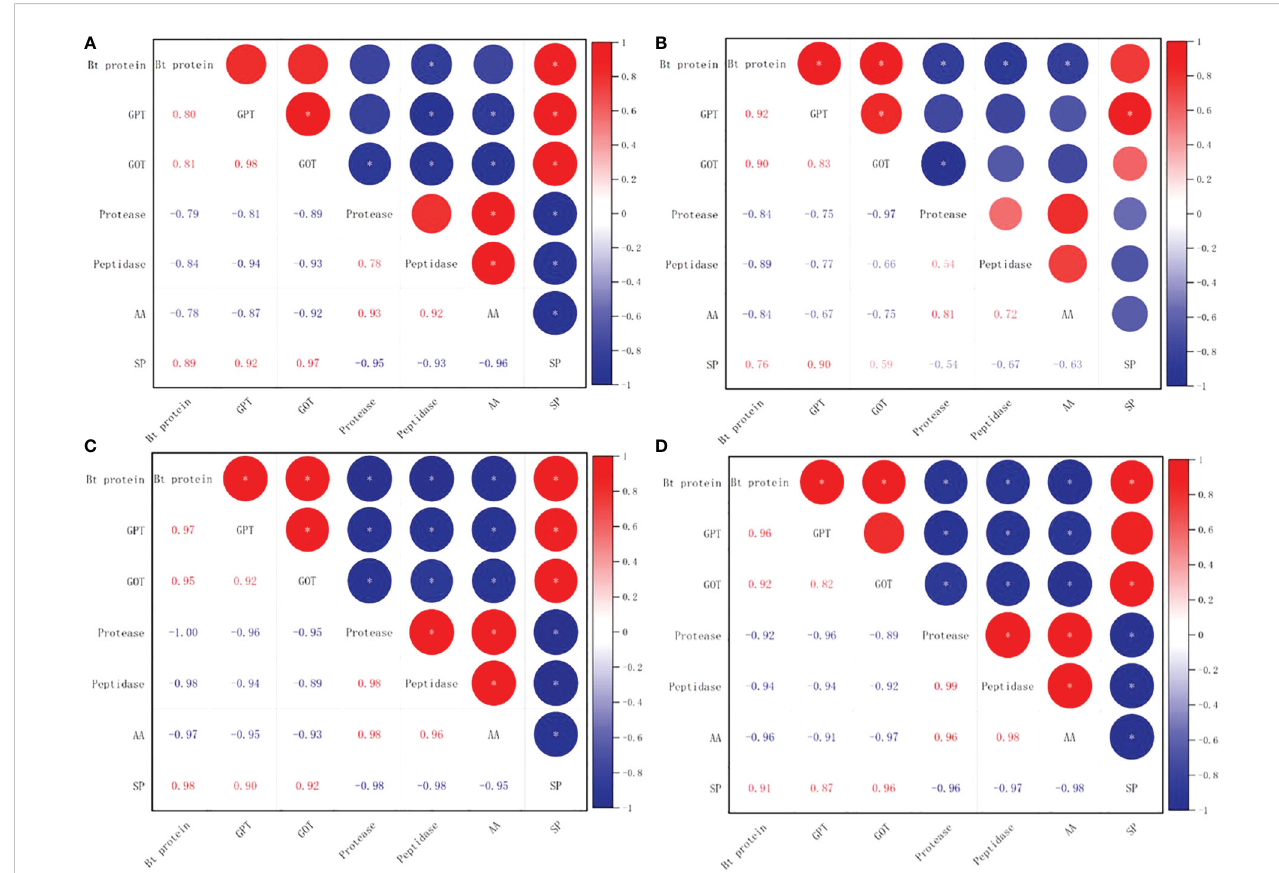
FIGURE 13 Correlations between Bt insecticidal protein content and nitrogen metabolism related parameters in 2020 ( A :SK1, B :SK3) and 2021 ( C :SK1, D :SK3). GPT, Glutamic-pyruvic transaminase; GOT, glutamate oxaloacetate transaminase; AA, free amino acid; SP, soluble protein. Asterisks indicate signi fi cance at the 0.05 (*)